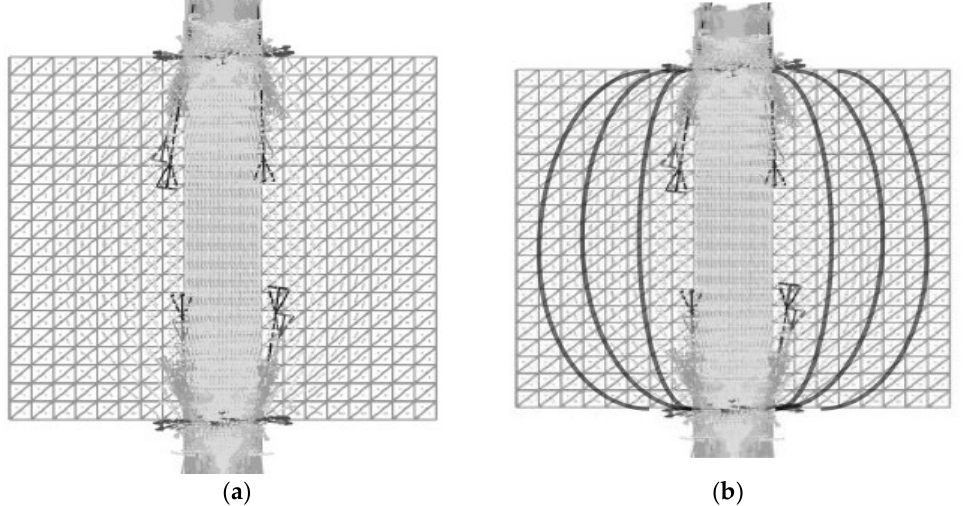
Figure 3. Stress distribution: ( a ) stress distribution results; ( b ) bold display of stress distribution trajectory.